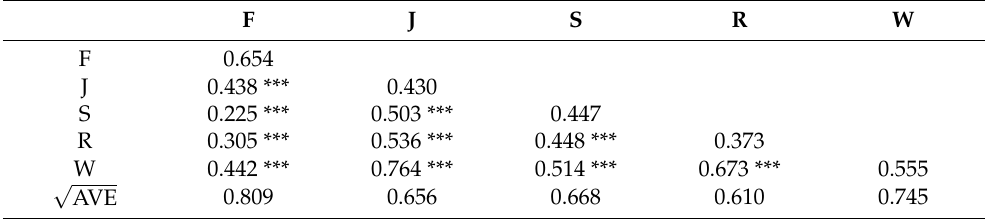
Table 8. Table of Normalized Path Coefficients Between Optimal Measurement Model Factors.